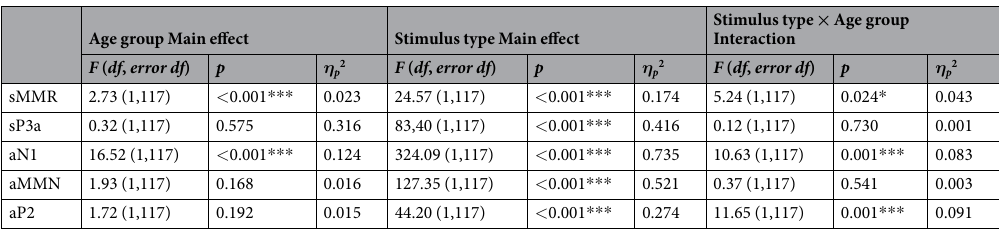
Table 2. Results of the two-way repeated measures MANOVA of later somatosensory and auditory ERP components in response to deviant and standard stimuli in young and older adult groups. Df, degrees of freedom; η p 2 , partial eta squared; p , statistical significance; * p < 0.05; ** p < 0.01; *** p <